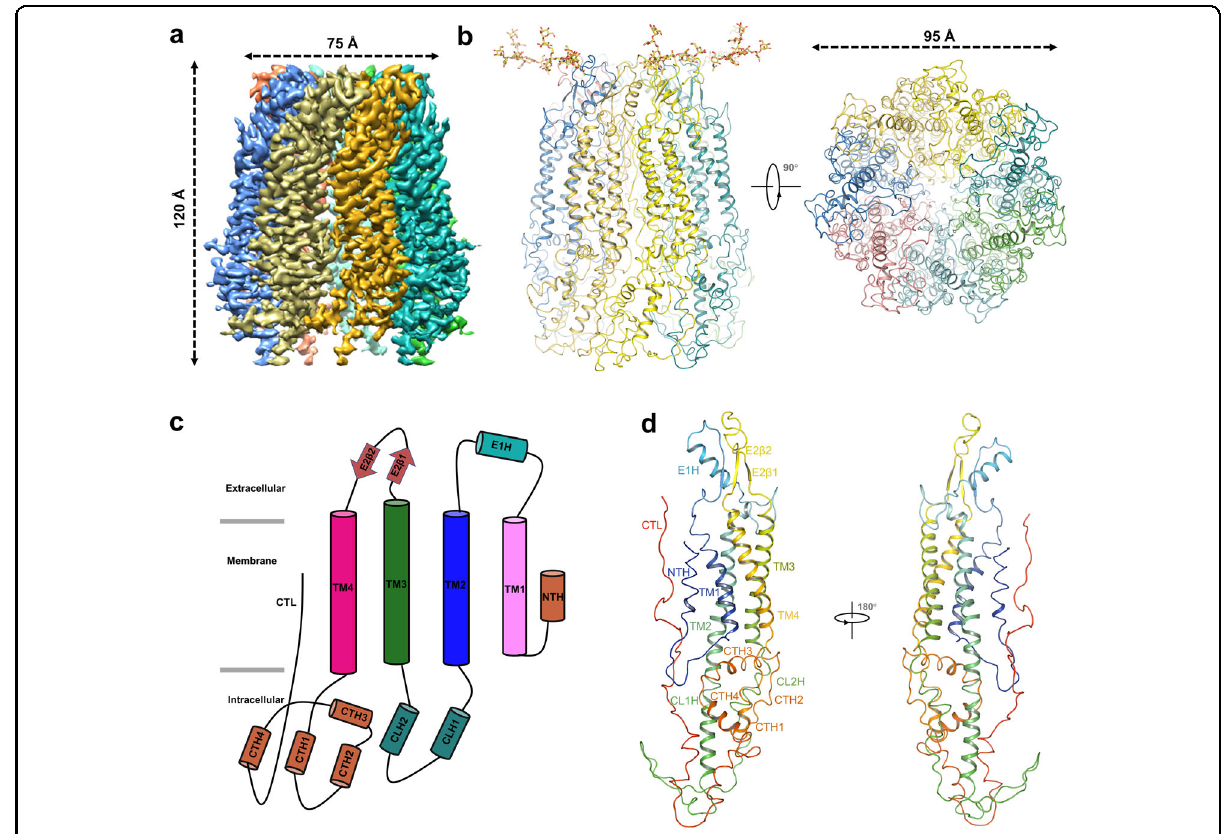
Fig. 1 Cryo-EM structure of the hPANX1 channel. a Cryo-EM density map of hPANX1 at a resolution of 3.15 Å with each subunit color-coded from a side view. b Ribbon representation of the heptameric hPANX1-MD structure from the side view and the bottom view with each subunit color- coded. The glycosylation moieties are shown as sticks. c Schematic representation of the secondary structure of hPANX1. Cylinders and arrows indicate helices and β -strands, respectively. d Ribbon representation of the hPANX1-MD protomer structure with different regions